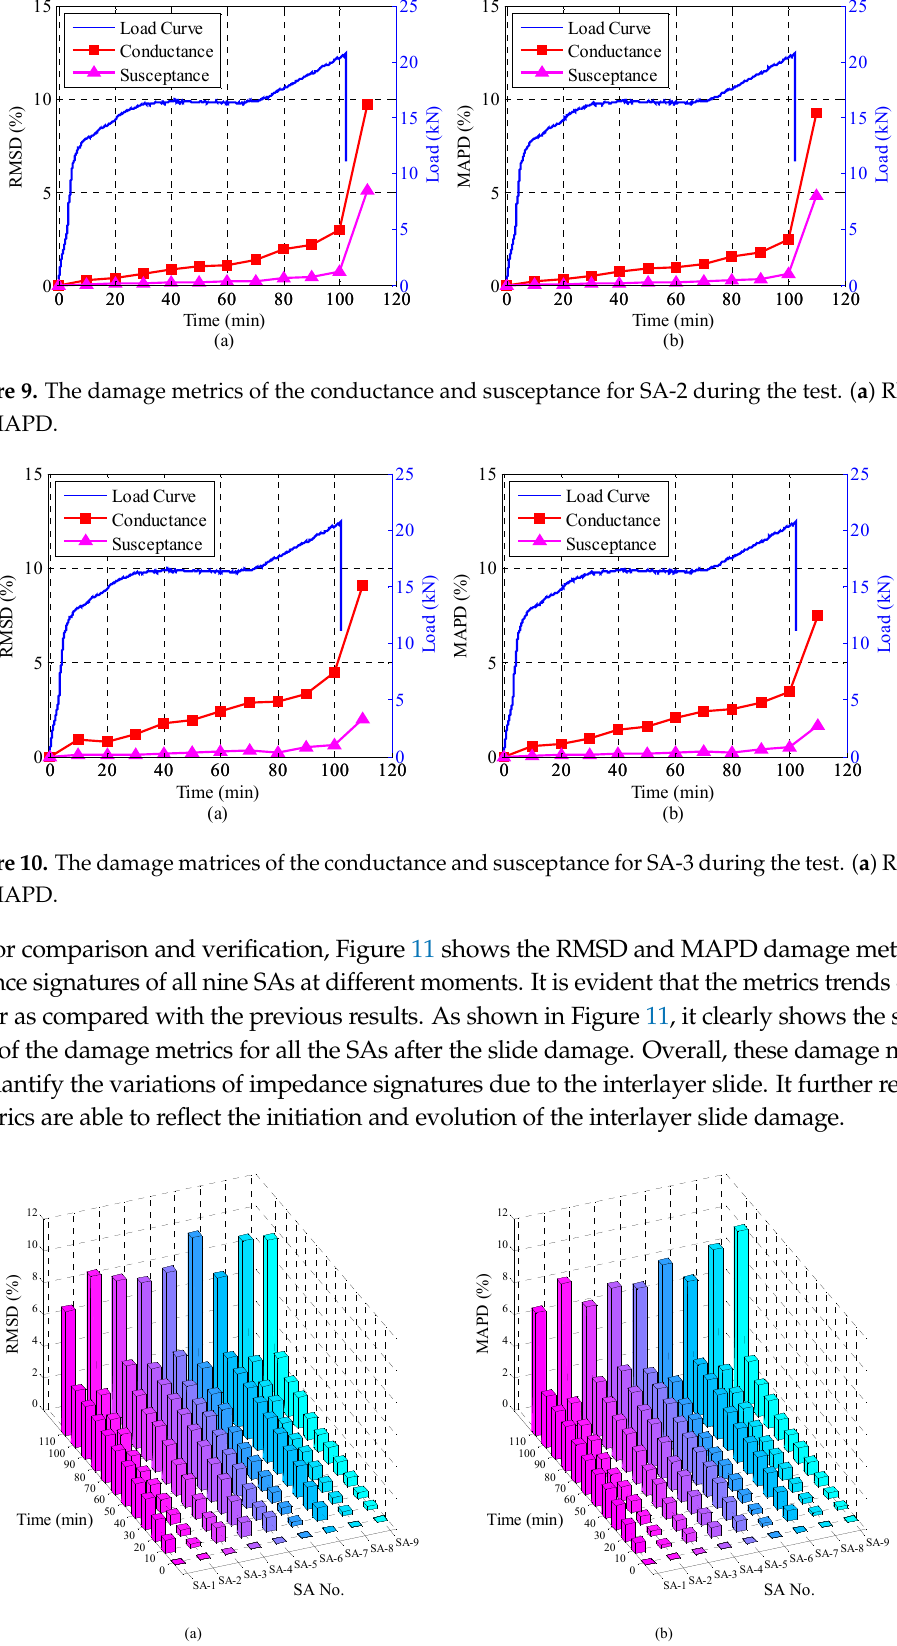
Figure 8. The damage metrics of the conductance and susceptance for SA-1 during the test. ( a ) root mean square deviation (RMSD), ( b ) mean absolute percentage deviation (MAPD).